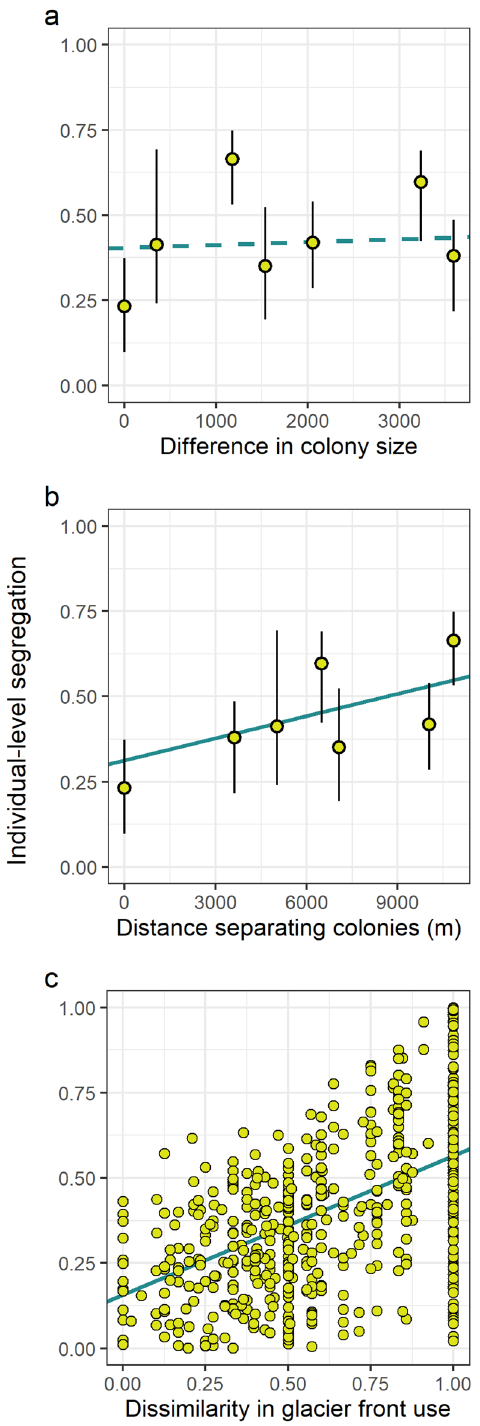
Figure 4. Spatial segregation level (i.e., 1 − Bhattacharyya coefficient) of breeding kittiwake foraging ranges as a function of ( a ) the difference in colony size (i.e., Manhattan distance), ( b ) the distance separating colonies, and ( c ) the dissimilarity in glacier front use between each individual dyad. Solid and dashed lines depict, respectively, the significant and non-significant partial slopes of the multiple regression on distance matrices. Intercepts of each slope have been adjusted for illustration using as reference the mean of the remaining covariates. Symbols represent the median and associated 25th and 75th percentiles in panels ( a ) and ( b